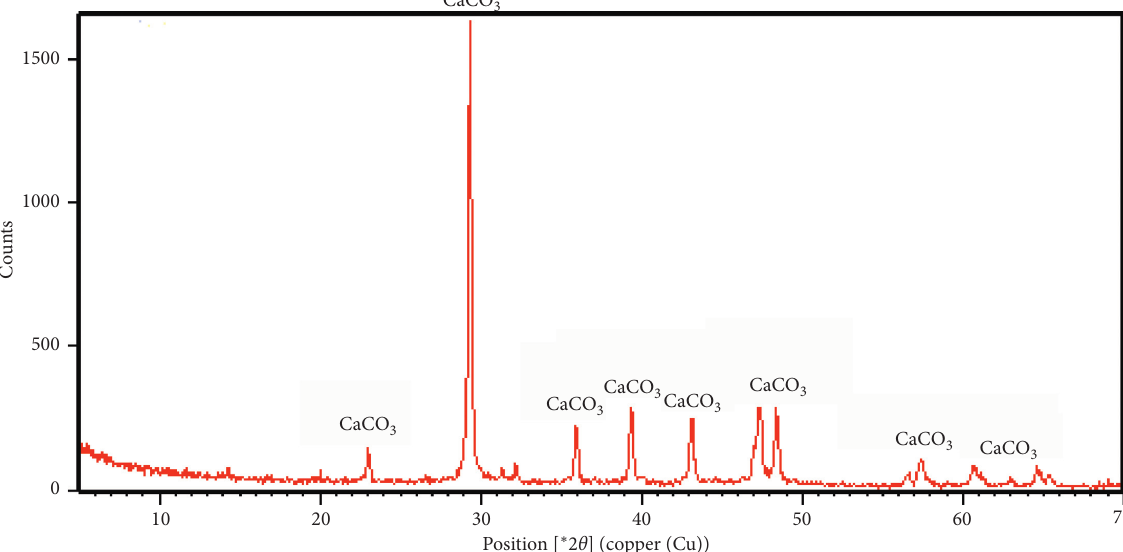
Figure 1: XRD patterns of sugar scum